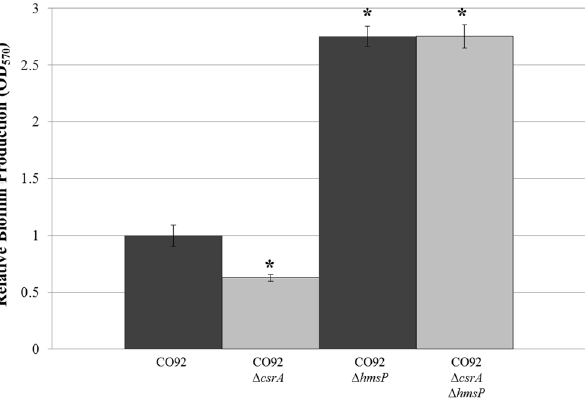
Fig 9. Deletion of hmsP Enables Excessive Biofilm Production in the csrA -deficient Mutant. Relative biofilm production of CO92, CO92 Δ csrA , CO92 Δ hmsP , and CO92 Δ csrA Δ hmsP following 24 hours post- inoculation in HIB medium. Error bars reflect standard deviation from the mean of 2 independent experiments, each consisting of 6 technical replicates. * P-value < 0.005 as determined by Tukey ’ s HSD post-hoc